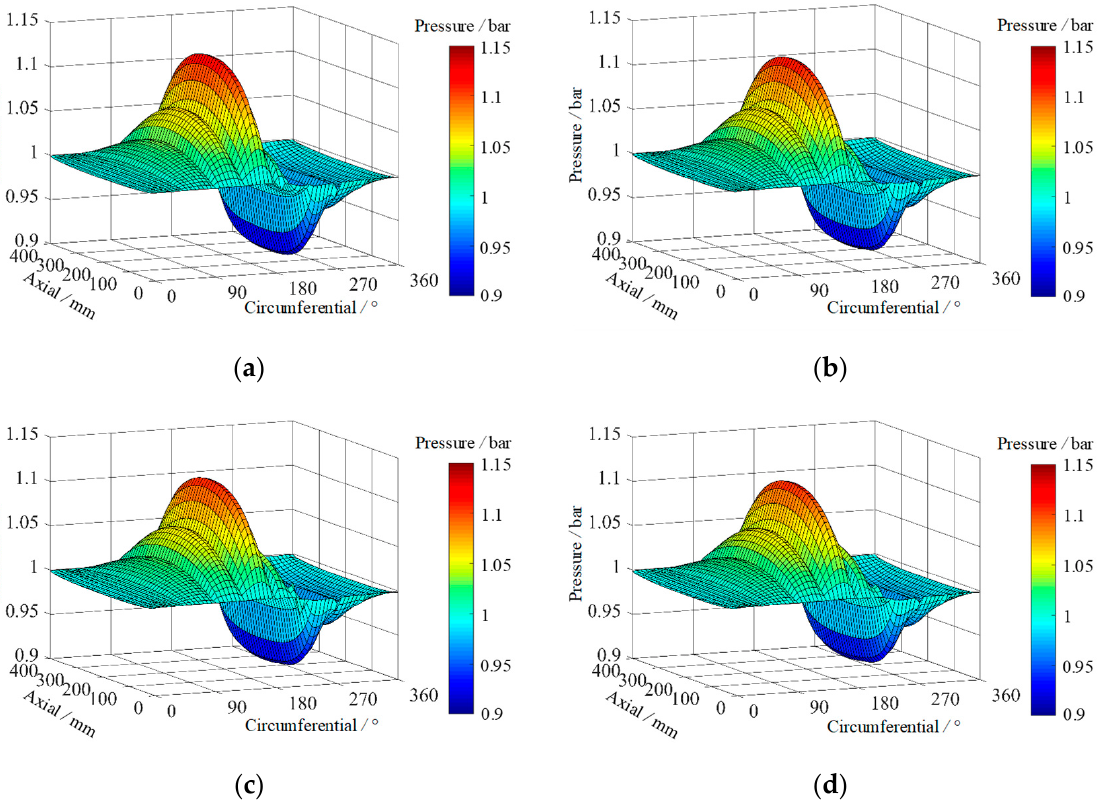
Figure 10. Comparison of lubricating film pressure under different slip lengths; ( a ) non-slip; ( b ) L s = 4 µ m; ( c ) L s = 8 µ m; ( d ) L s = 12 µ